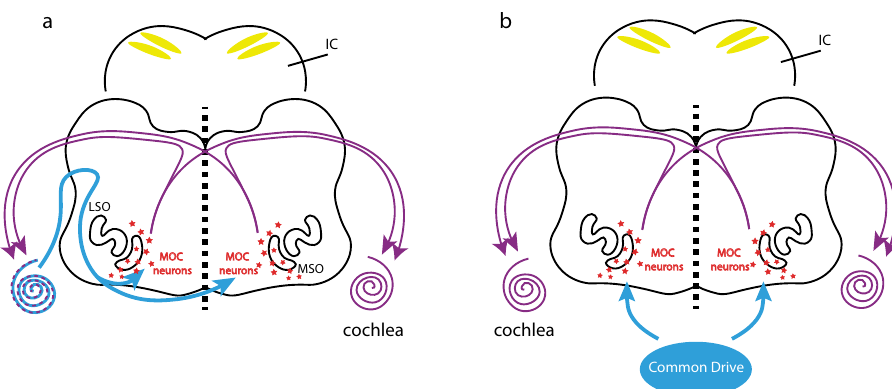
Fig. 6 Models of MOC-mediated bilateral coupling of spontaneous activity. a Model of the medial-olivocochlear (MOC) efferent circuits mediating bilateral coupling of spontaneous activity. MOC neurons are driven by and provide bilateral feedback to both cochleae, thus coupling the two sides of the auditory system. Schematics are at the level of the brainstem section where MOC neurons reside. LSO lateral superior olive, MSO medial superior olive. Purple curved arrows: cochleae receiving bilateral MOC modulation. IC is shown in the background with bilateral calcium bands presented. Driving inputs from cochleae to the MOC labeled as blue curved arrows. b Similar model as in ( a ). In this model, bilateral coupling derives from an external, common source (labeled in blue) to MOC neurons that is